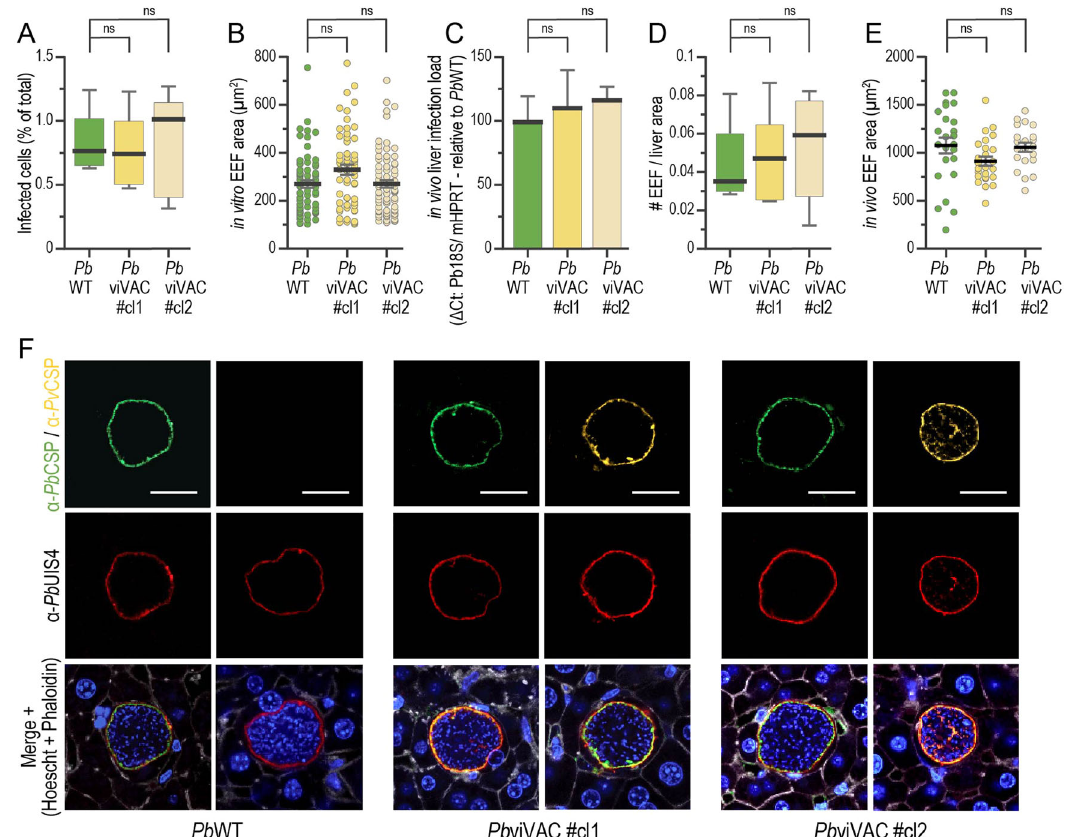
Fig. 3 Pb viVac in vitro and in vivo pre-erythrocytic development and expression of Pv CSP. A, B Compared in vitro infectivity and parasite development of Pb WT and Pb viVac parasites in HepG2 human hepatoma cells ( n ≥ 3 coverslips per group); Compared in vivo infectivity and development of Pb WT and Pb viVac parasites as determined by qPCR analysis of infected mouse livers (C) , quanti fi cation of the number of parasites per liver area (D) , and development of hepatic parasites (E) ( n = 3 mice per group); (F) Representative immuno fl uorescence microscopy images of Pb WT and Pb viVac parasites developing in mouse livers 48 hpi. Immuno fl uorescence staining with the anti- Pb CSP (green) and anti- Pv CSP VK210 (yellow), as well as with anti- Pb UIS4 antibodies, con fi rms the expression of both proteins by Pb viVac and their localization to the parasite membrane. Scale bar: 20 µm. Measurements were taken from distinct samples. The boxes correspond to the 25th and 75th percentiles in ( A ) and ( D ) and the black lines/bars and grey lines correspond to mean and standard error of the mean, respectively (ns: not signi fi cant, Mann – Whitney U